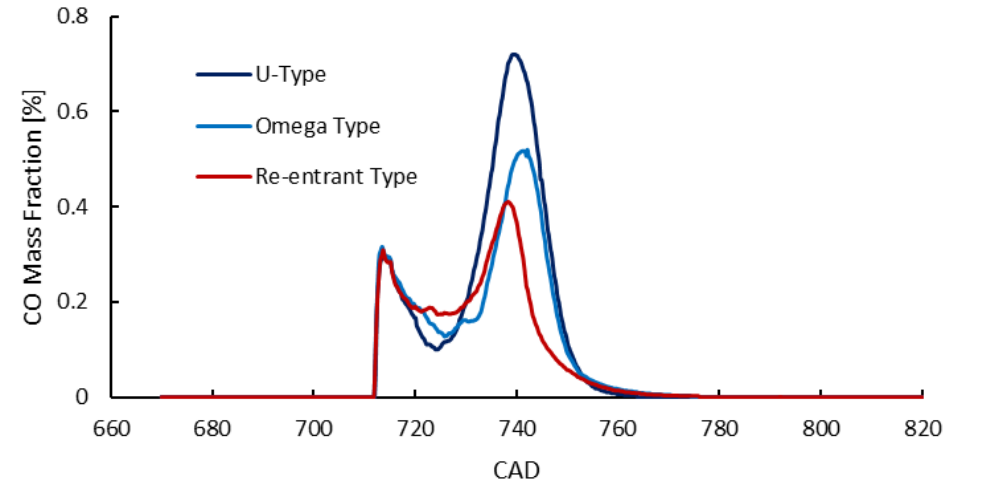
Figure 14. CO emissions diagrams for the three various piston types.